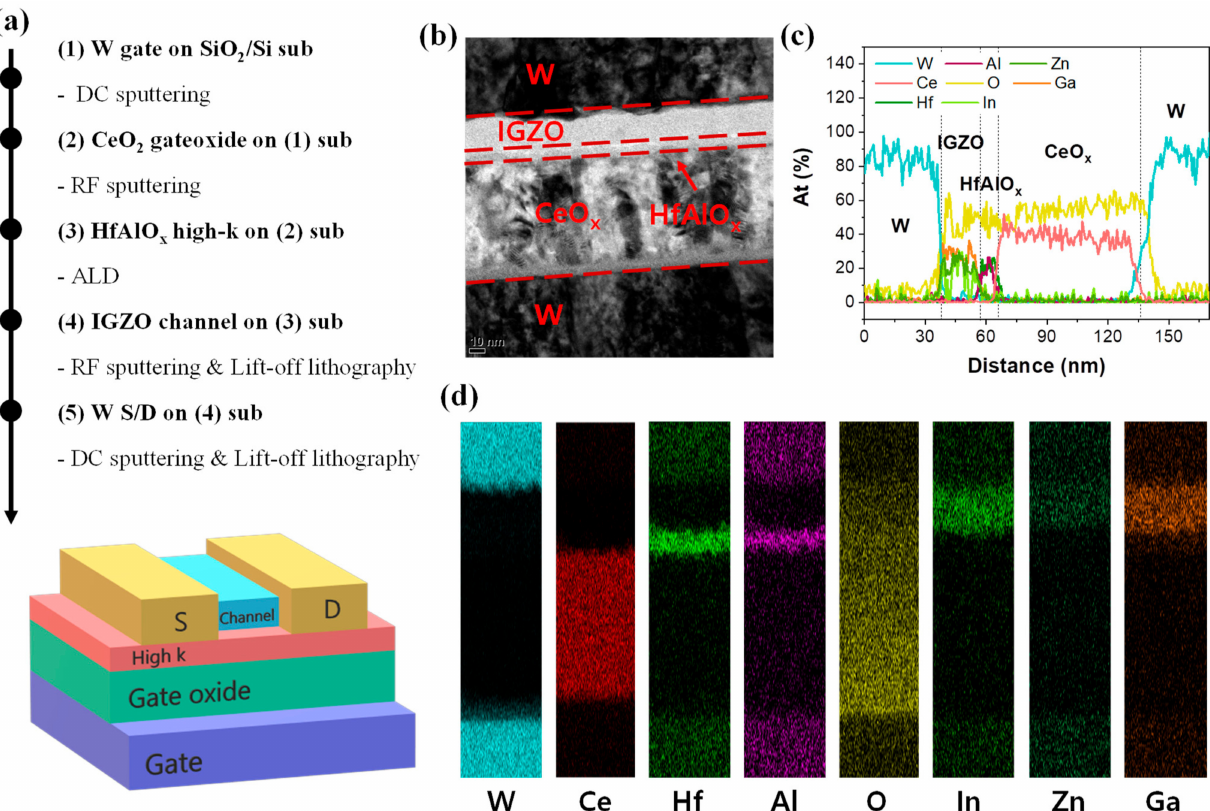
Figure 1. ( a ) The schematic showing 3-terminal synaptic device structure and the brief fabrication process; ( b ) HR-TEM image; ( c ) a line scanning of the atomic ratio of each element; and ( d ) an EDS mapping image. Each element exhibits colors in ( c ) and ( d ) in match; for example, the W in ( c ) and ( d ) is sky